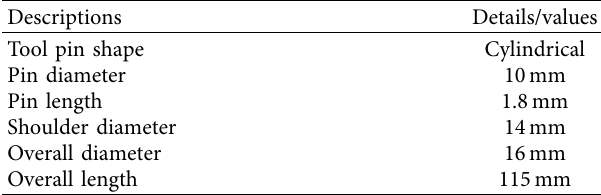
Table 3: Details of FSW